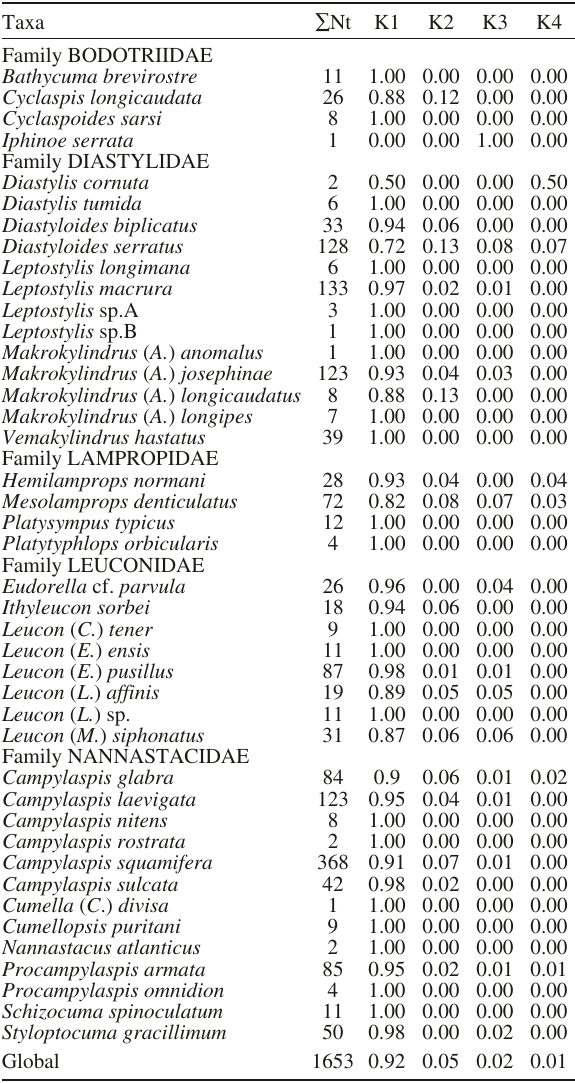
Table 4. – Index (K) of swimming activity (see text) calculated for cumacean species sampled by a sledge in the 10-40, 45-85, 90-110 and 115-145 cm near-bottom water layers during the ESSAIS and ECOFER surveys. ∑ Nt, total number of specimens (cumulative values from all available water layers and stations, excluding